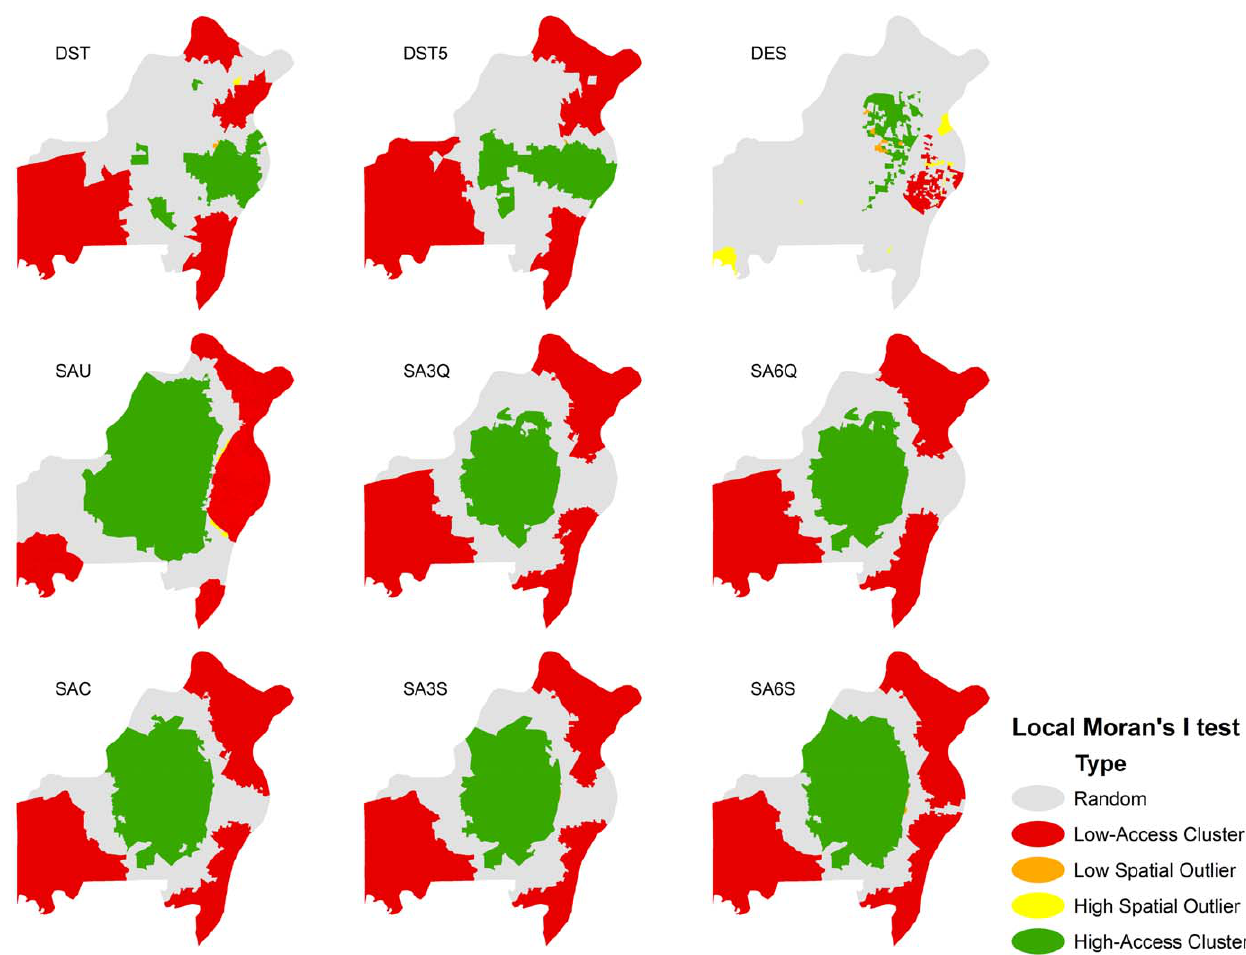
Figure 2. Spatial patterns (Anselin local Moran’s I tests) of nine GIS-based measures in access to mammography in St. Louis.